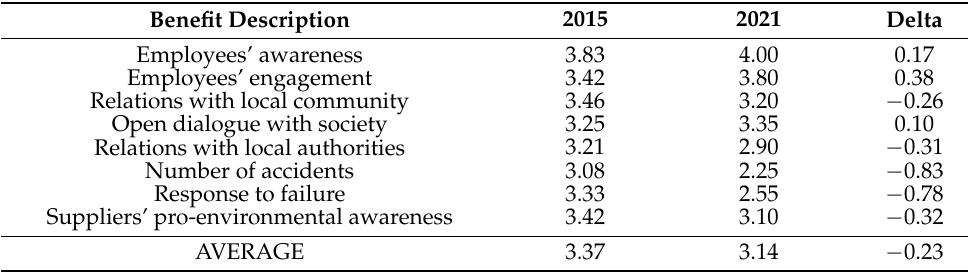
Table 6. Social benefits of the